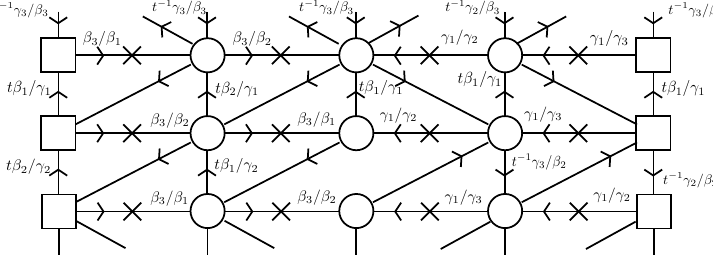
Figure 7 . Flux domain wall for F tot = (1 ; 1 ; (cid:0) 2) (cid:12) in the a(cid:14)ne A 2 quiver theory. The permutations in the (cid:12)rst and second domain walls are (cid:27) t 1 = (cid:27) t 2 = (1 2) and thus (cid:27) t 1 (cid:27) t 2 = 1.